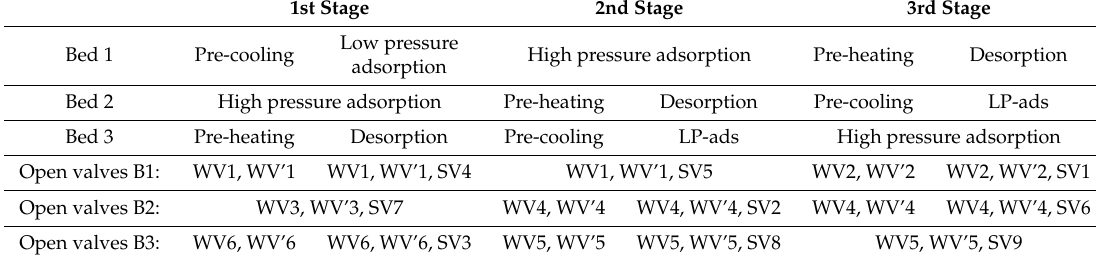
Figure 4. Three-bed two-evaporator adsorption chiller scheme. SV—steam valves, WV—water valves.